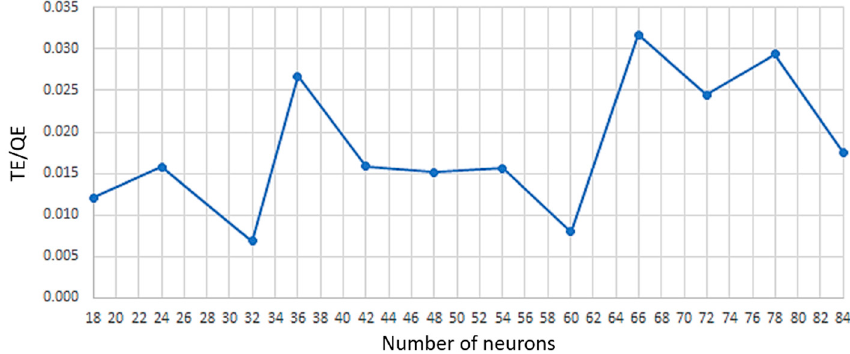
Figure 3. Calculation of the TE/QE ratio for the different SOM sizes evaluated.